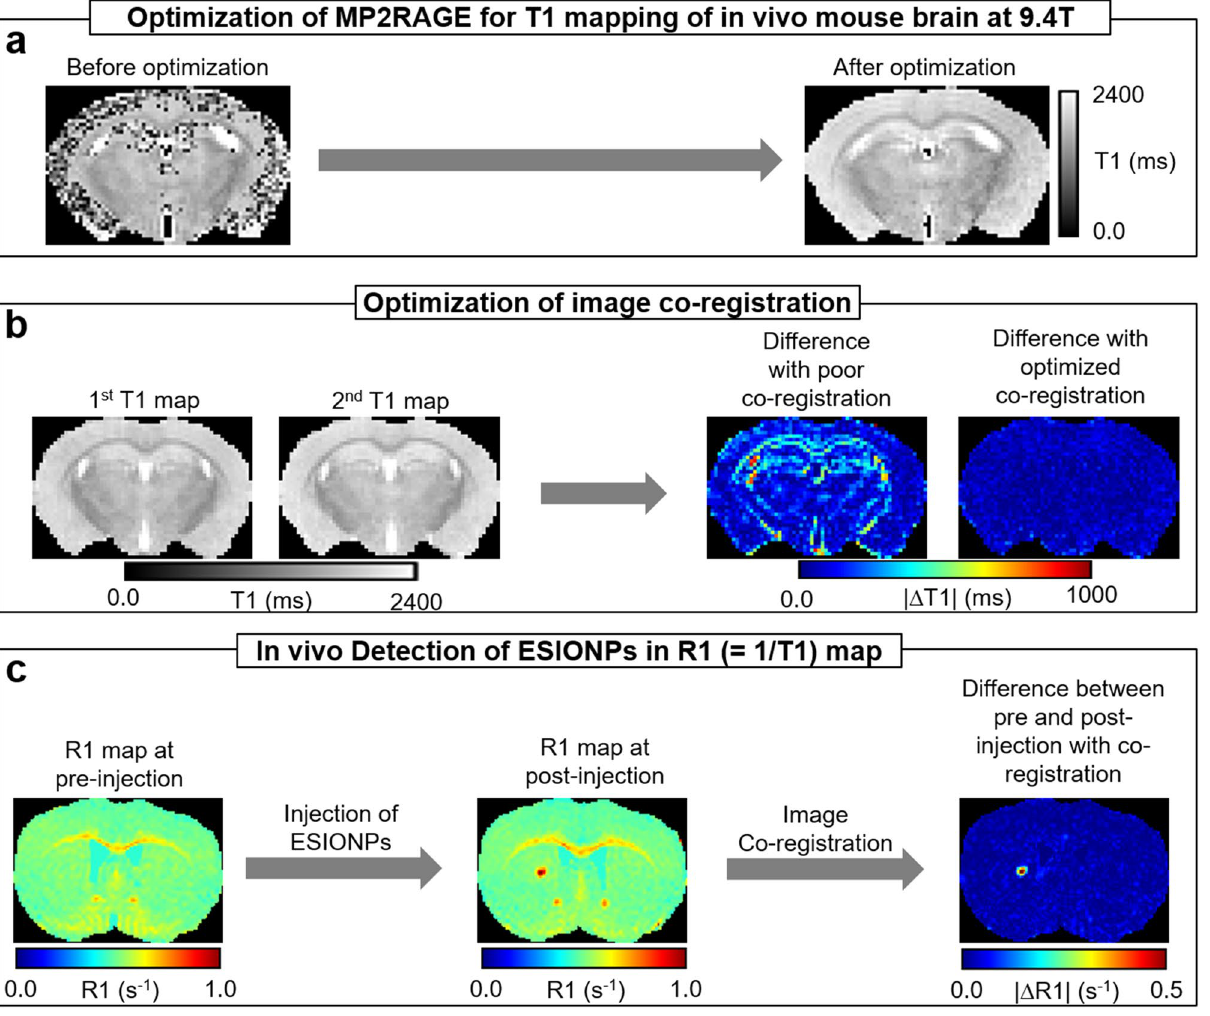
Figure 1. Schematic of experimental procedures. ( a ) Optimization of MP2RAGE for T1 mapping of in vivo mouse brain at 9.4 T (see Supplemental Figs. S1–S6 and Fig. 2). ( b ) Optimization of image co-registration (see Figs. 3, 4, 5). ( c ) In vivo detection of ESIONPs in R1 (= 1/T1) map (see Figs. 6, 7,